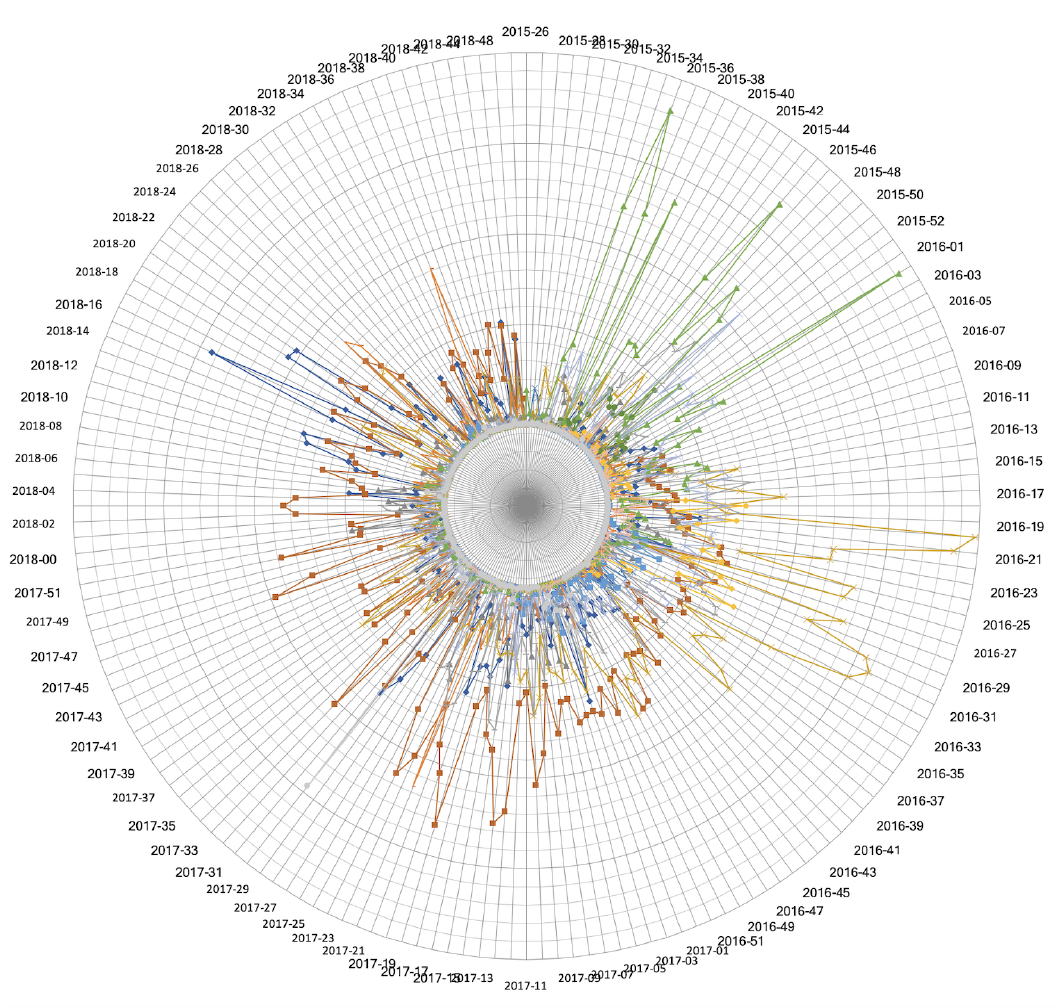
Figure 3. Weekly disease incidence for 15